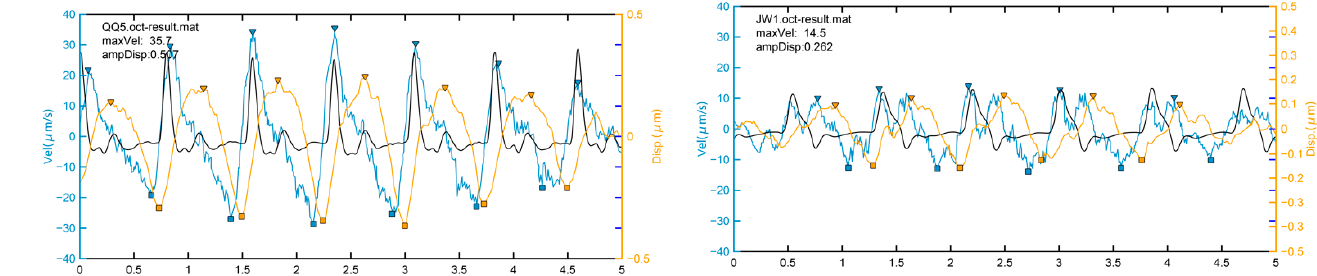
Figure 2. Representative of trabecular motion (TM) synchronized with heartbeat. The TM motion is synchronized with the heartbeat. The black curves represent the heartbeat. The blue curves indicate the instantaneous velocity of the TM in each cycle, while the orange lines demonstrate the cumulative displacement of the TM, which moves away from the original location at each check point. The inverted triangle indicates the peak value of the traced curve, while the square presents the valley value. The positive of the velocity or the displacement represents the TM moving outwards to the sclera in the systole; the negative velocities represent the TM moving inwards towards the anterior chamber during the diastole. The maximum velocity means the maximum instantaneous velocity during a cycle. The figures show two representatives of the TM motion in normal ( left ) and POAG patients ( right ).